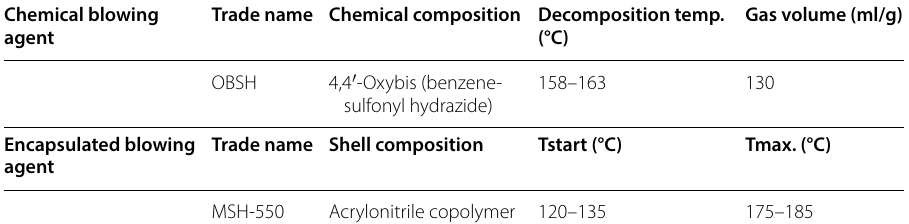
Table 1 Specification of blowing agent Chemical blowing agent